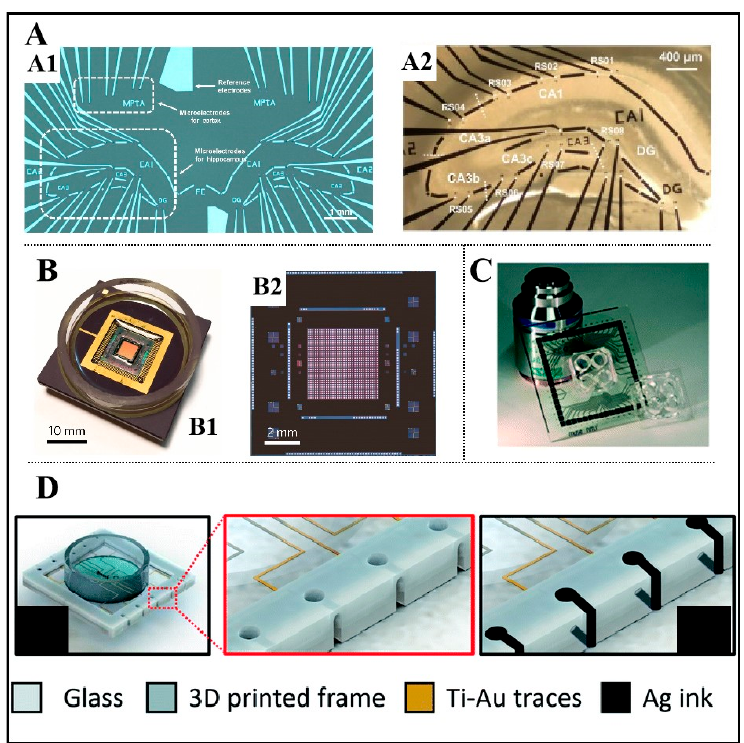
Figure 3. Future development direction of in vitro MEAs. ( A ) The internal structure ( A1 ) and the real object ( A2 ) of an MEA dedicated to rat hippocampal slices [57]. Reproduced with permission from He, Sensors and Actuators B: Chemical; published by Elsevier, 2021. ( B ) The object ( B1 ) and internal structure ( B2 ) of a high-density CMOS microelectrode array [60]. Reproduced with permission